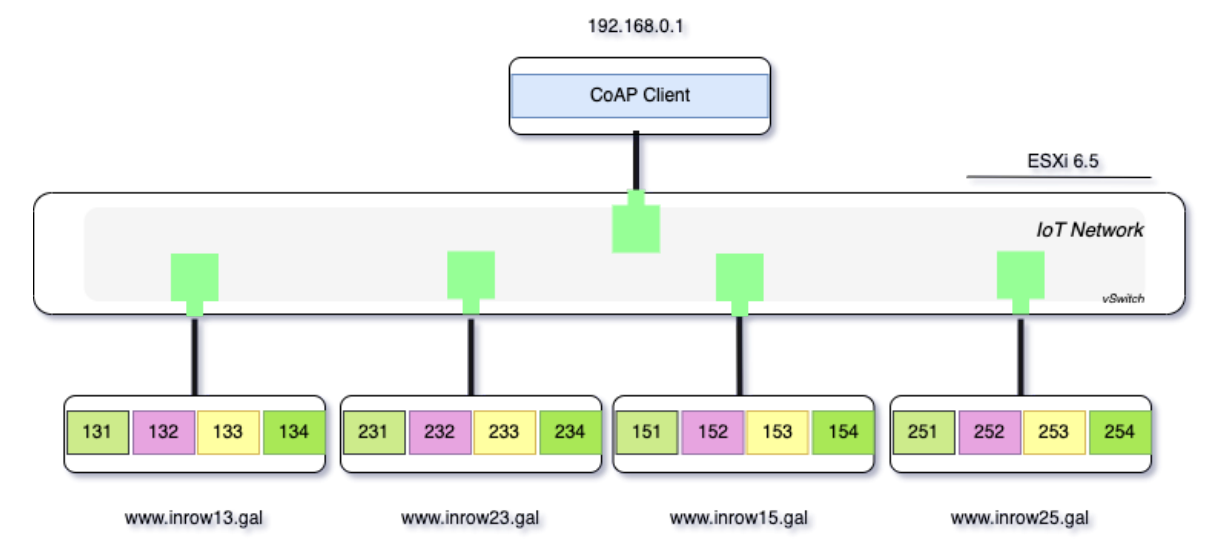
Figure 1. Virtual scenario, including a CoAP client and four CoAP servers